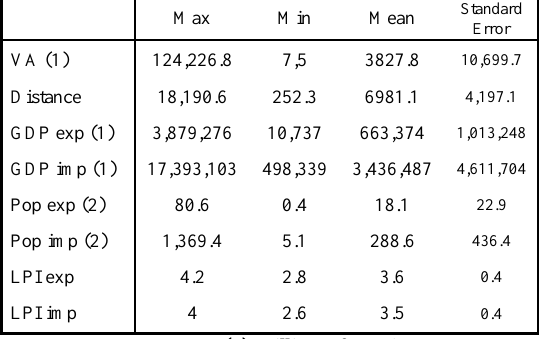
Table 4A: Main Statistics 2014 Total Sample